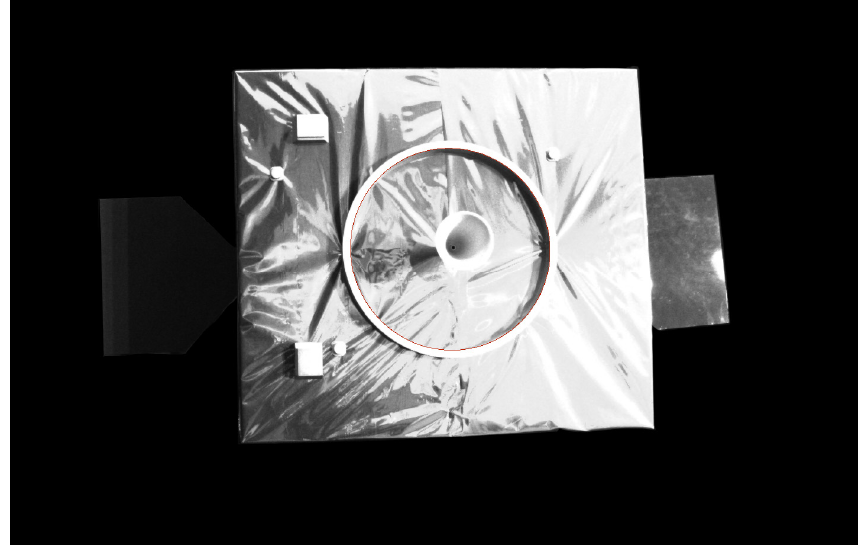
Figure 10. The image of the docking ring detection.